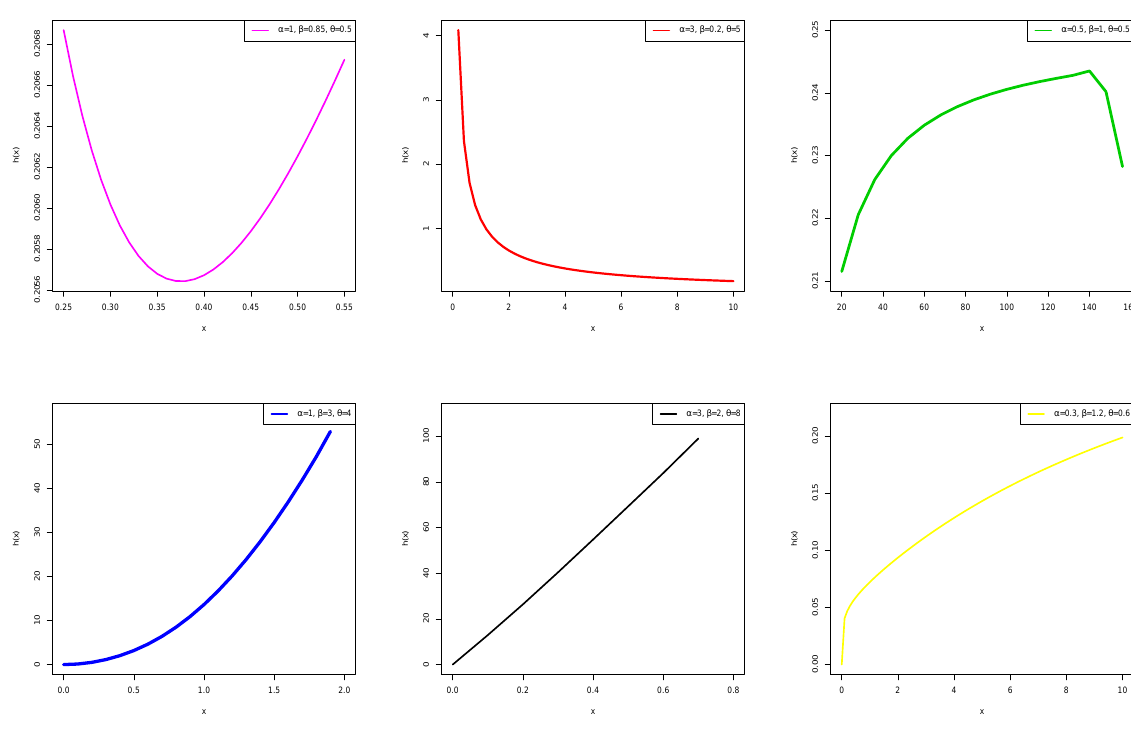
Figure 2 - Plots of the LiW hrf for selected parameter